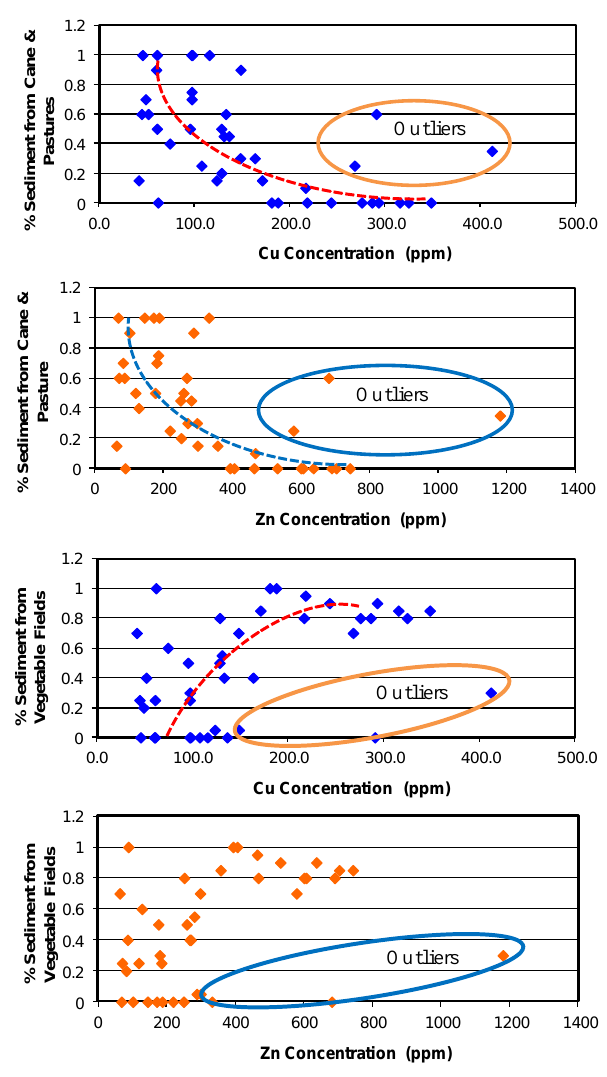
Fig. 12. Relationship between Cu and Zn concentrations and per- cent relative contribution from vegetable and pasture plus cane